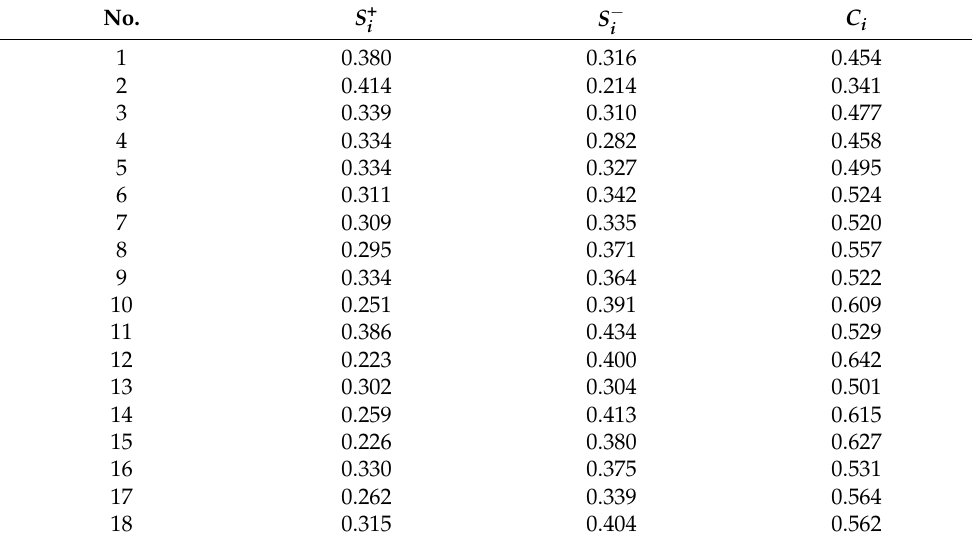
Table 12. Separation measure of positive ideal solution, negative ideal solution, and relative closeness